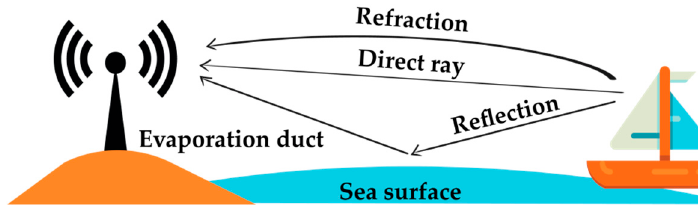
Figure 1. Radio wave propagation near the sea surface.